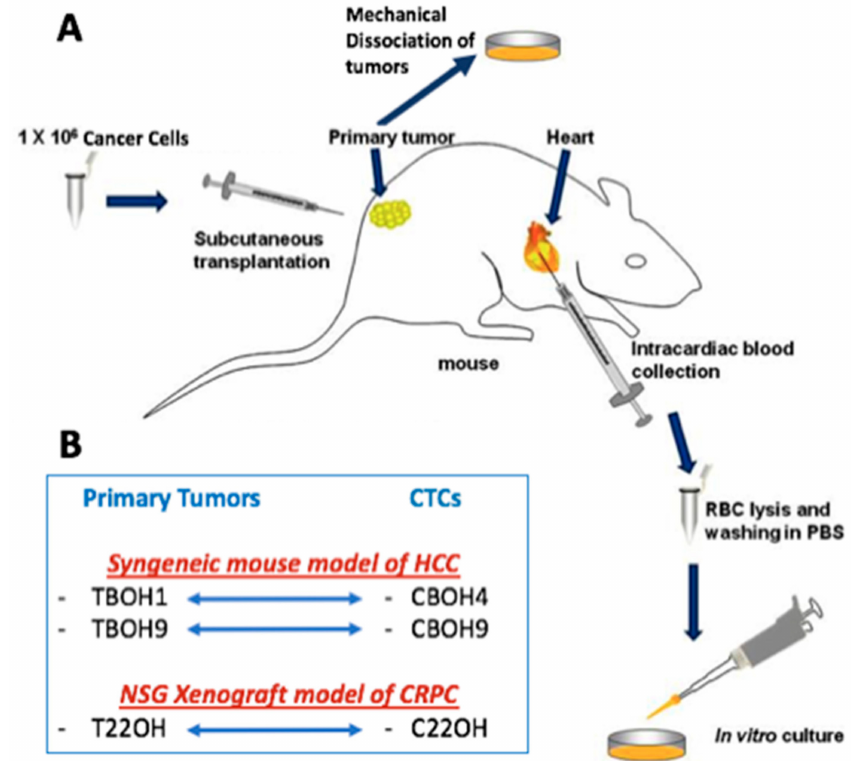
Figure 1. Establishment of novel primary tumor-derived cell lines and circulating tumor cell